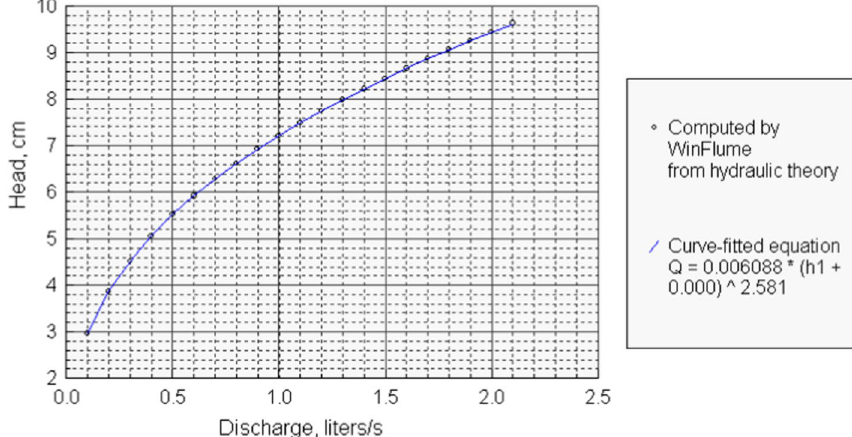
Fig. 7 Obtaining the flow- Ashle-Flume curve and formula by WinFlume